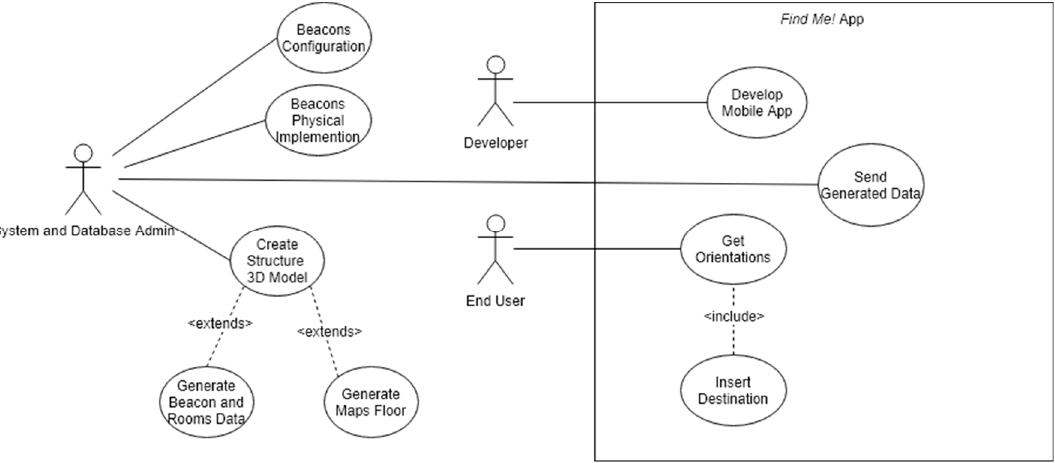
Figure 1. Find Me! uses a case diagram.